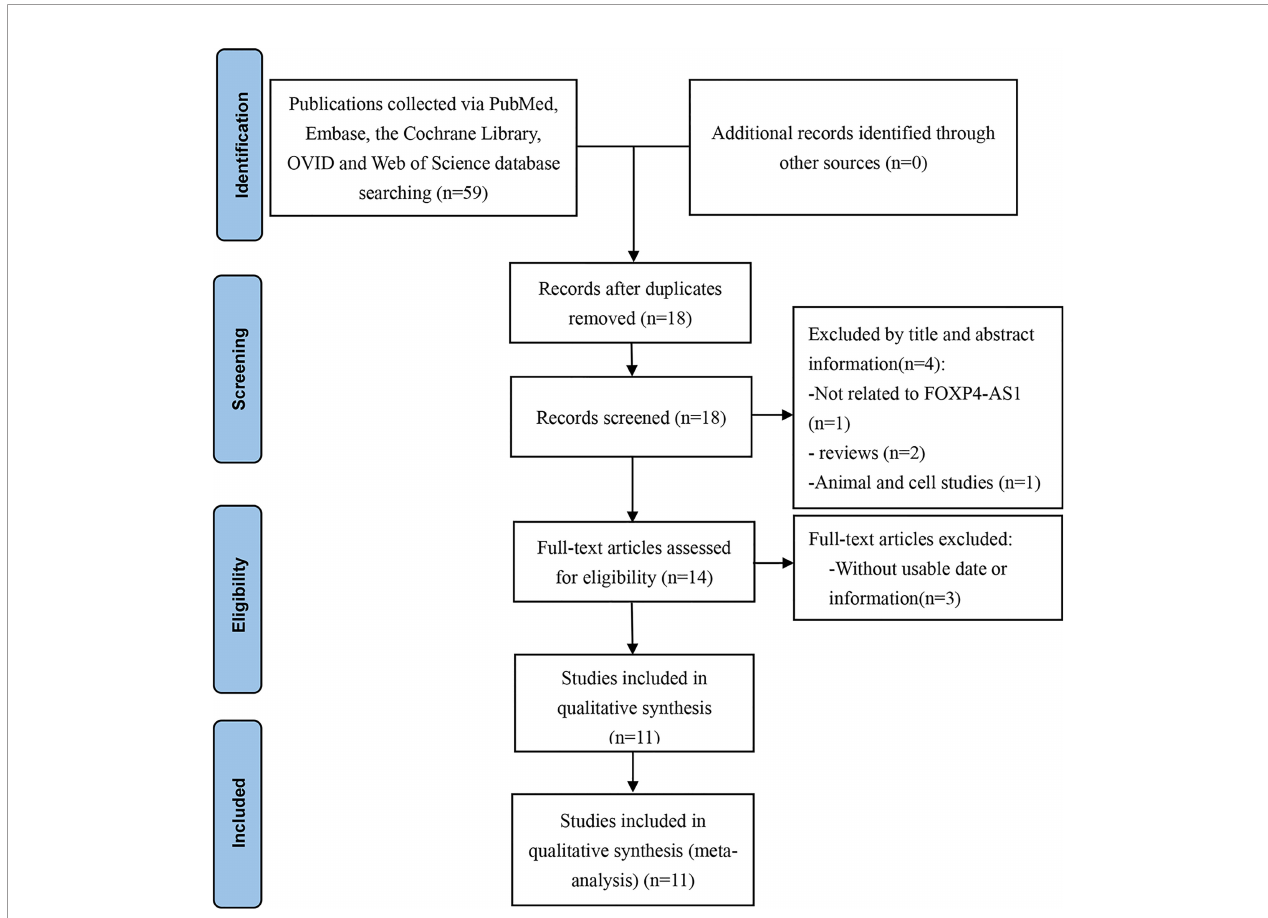
FIGURE 1 | Flow diagram of this